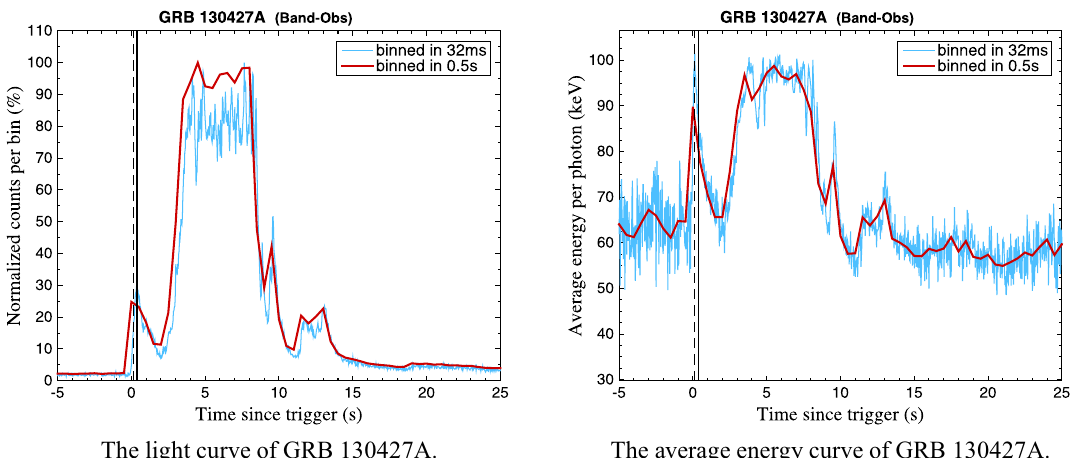
The light curve of GRB 130427A. The average energy curve of GRB 130427A. Fig. 9 The light curve and average energy curve of GRB 130427A in Band-Obs. The vertical solid lines refer to t obs /( 1 + z ) of Criterion 0 (the first main peak of the light curve) and the vertical dashed lines refer to t obs /( 1 + z ) of Criterion 2 (the significant peak of the average energy